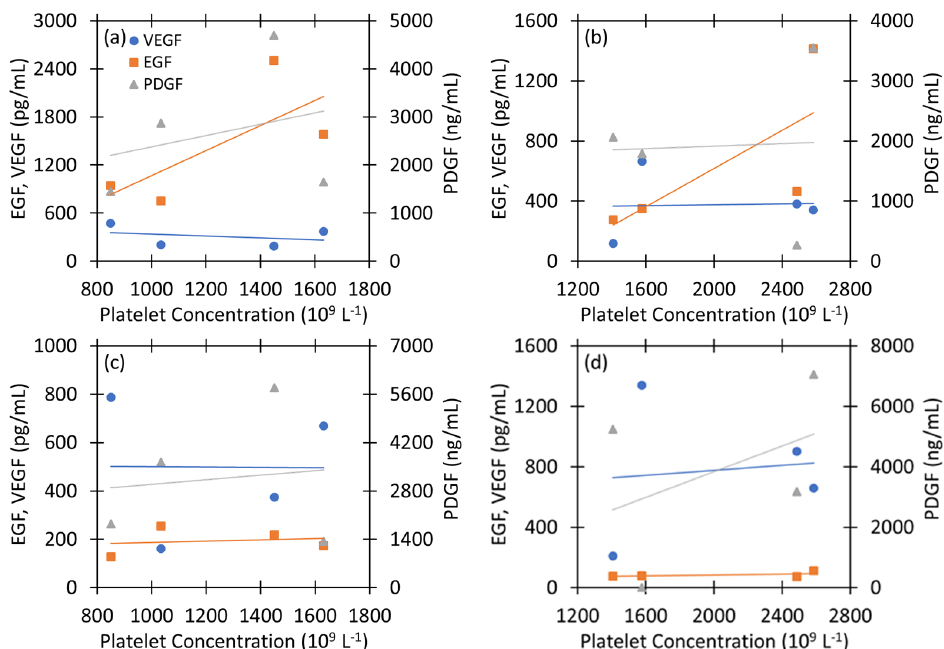
Figure 5. Assessment of the linear correlation of EGF, VEGF, and PDGF release with platelet concentration for the four donors for ( a ) the Harvest PRP and PEF A, ( b ) the EmCyte PRP and PEF A, ( c ) the Harvest PRP and BT, and ( d ) the EmCyte PRP and BT. Generally, EGF increased more strongly with donor platelet concentration under PEF activation than with BT activation, while PDGF and VEGF exhibited more variability.